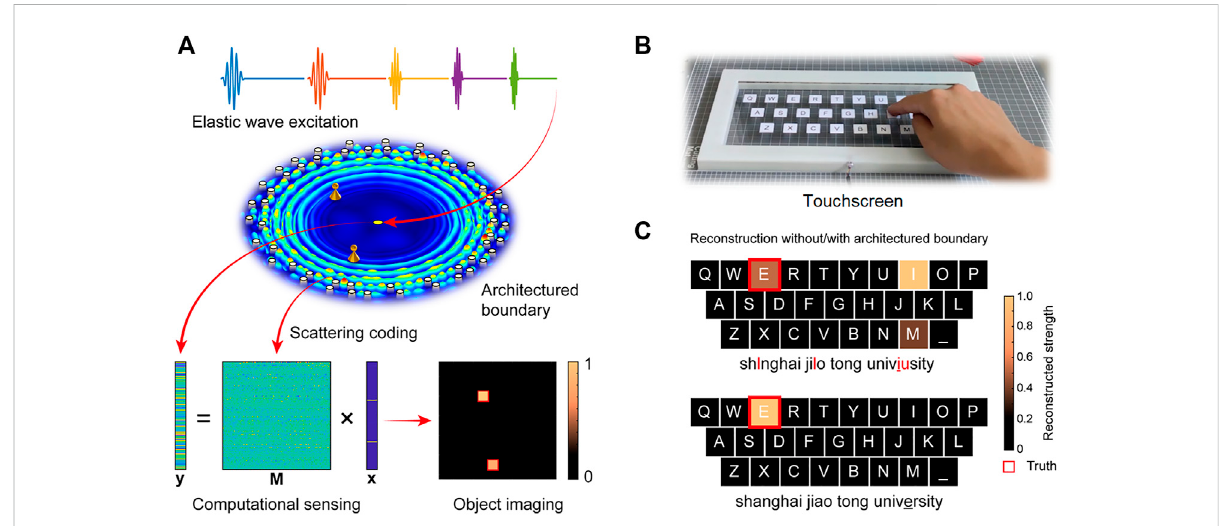
FIGURE 10 Scattering-coded architectured boundary for computational sensing of elastic waves [77]. (A) Concept of computational sensing for object imaging with architectured boundary. (B) The illustration of the designed touchscreen. (C) The reconstruction result of the input string without/with the architectured boundary. All the characters are correctly identi fi ed by using the touchscreen with architectured